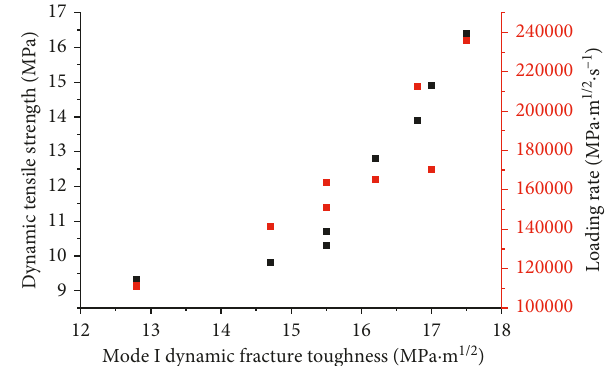
Figure 6: Relation between dynamic fracture toughness and dynamic tensile strength of 410m.